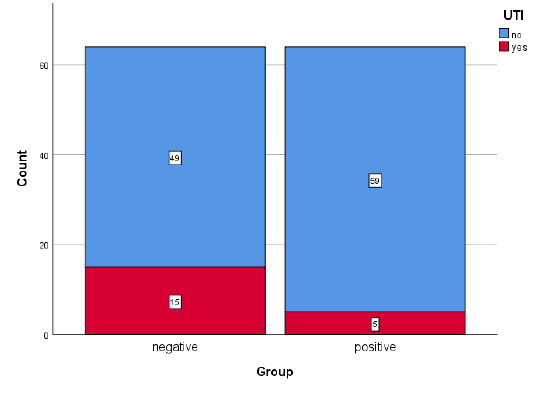
Figure 2. UTI in patients with gram-negative and gram-positive infection of dialysis.